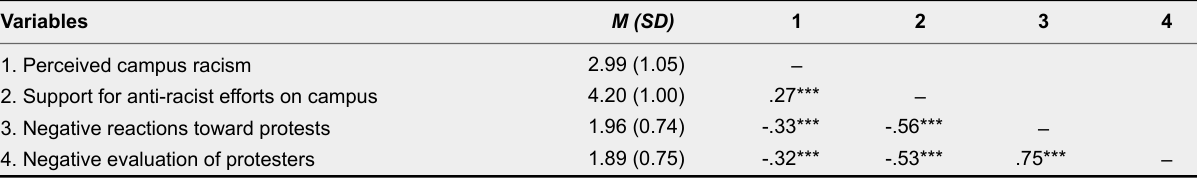
Means, Standard Deviations, and Intercorrelations Among Variables on the No-Protest Day